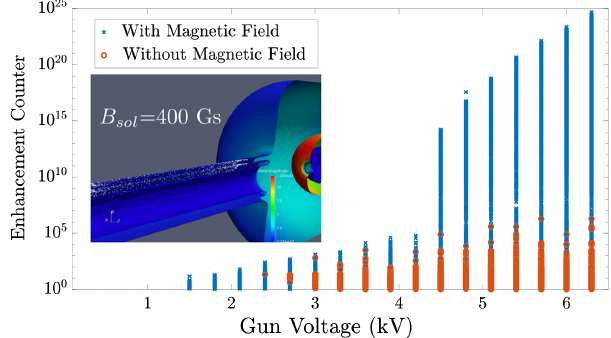
FIG. 12. Enhancement counter for the area of the FPC with (blue) and without (orange) external magnetic field.